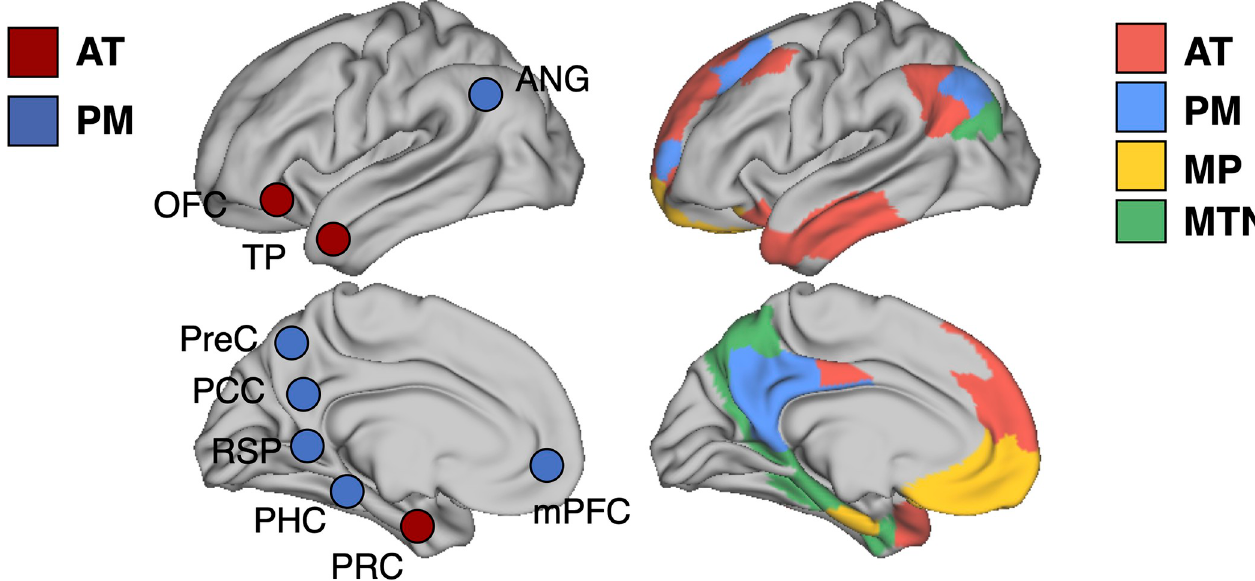
Fig 8. Left: hypothesized PM/AT divisions with PM nodes as blue and AT nodes as red [29,78].Right: data-driven network assignments. ANG, angular gyrus; AT, anterior temporal; mPFC, medial prefrontal cortex; OFC, orbitofrontal cortex; PCC, posterior cingulate cortex; PHC, parahippocampal cortex, PM, posterior medial; PRC, perirhinal cortex; PreC, precuneus; RSP, retrosplenial cortex; TP, temporal pole.